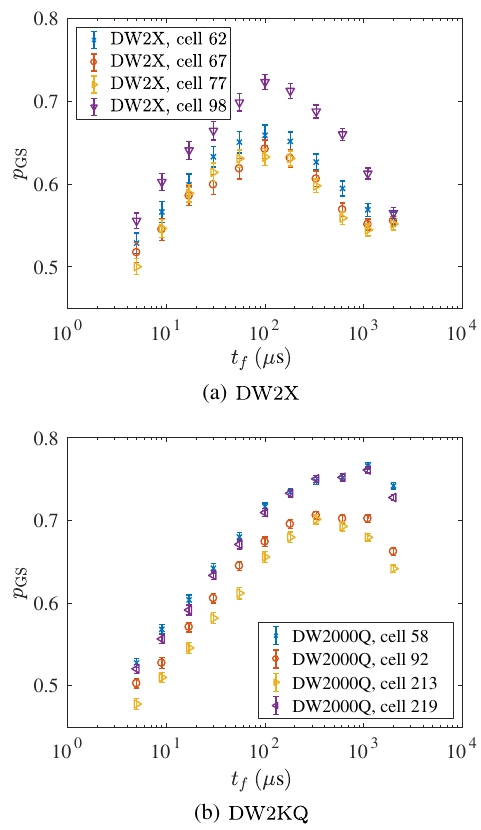
FIG. 14. Results for the 8-qubit gadget on the DW2KQ and DW2X. (a) The gadget on four different unit cells of the DW2X. (b) The gadget on four different unit cells of the DW2KQ. On both devices we used 1000 gauges with 1000 anneals per gauge. Error bars on the data points are 2 σ calculated using 1000 bootstraps of each